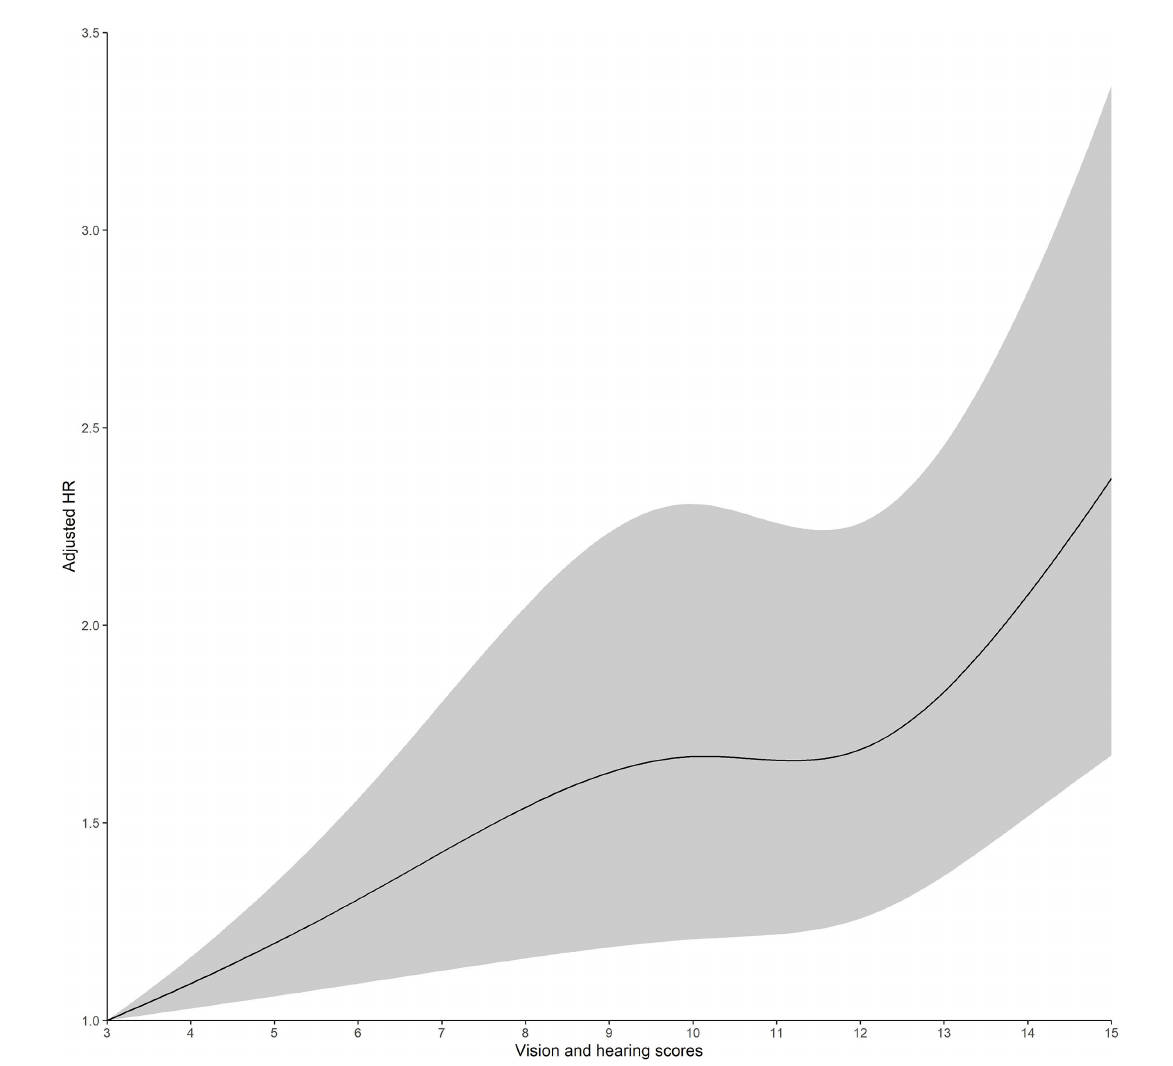
FIGURE2 Adjusted hazard ratios (HRs) of depressive symptoms, according to vision and hearing scores. Graphs show HRs for depressive symptoms adjusted for age, sex, residence, marital status, educational level, smoking history, alcohol consumption, hypertension, diabetes, heart disease, digestive disease, arthritis, wearing glasses, and wearing a hearing aid. Data were fitted by a restricted cubic spline Cox proportional hazards regression model. The vision and hearing scores range from 3 to 15, with the highest score representing impairment of vision and hearing. Solid lines indicate HRs, and dashed lines indicate 95%